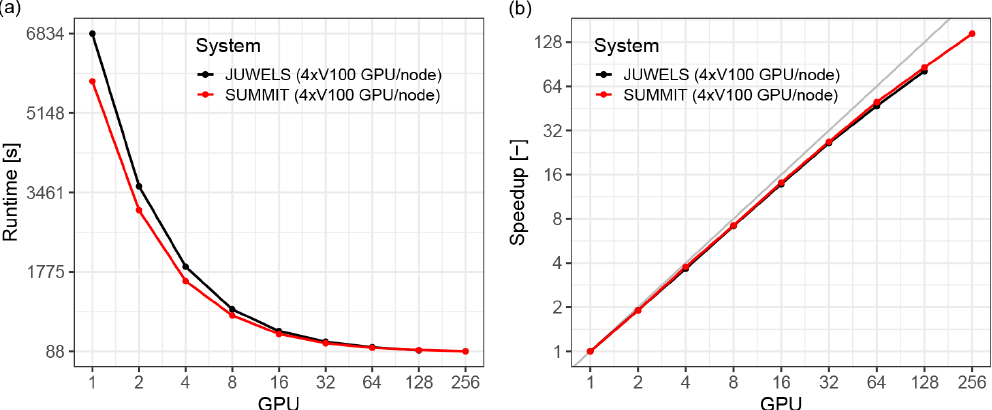
Figure 19. Runtime (a) and speed up (b) for a strong-scaling experiment with SERGHEI-SWE using GPUs on Summit and JUWELS for the long rainfall event. See Table 4 for details on the systems.